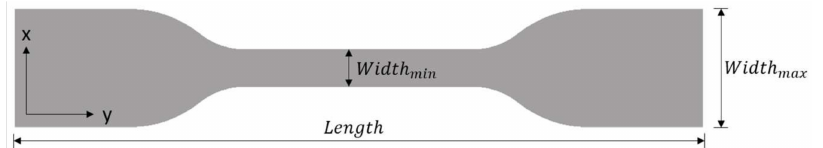
Figure 15. Ascertained dimensions for the dimensional error.